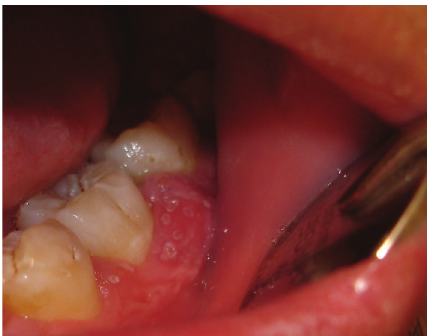
Figure 1: Clinical view of the periodontal abscess of the gingiva buccal attached to the lower left first molar and involving the adjacent papillae.